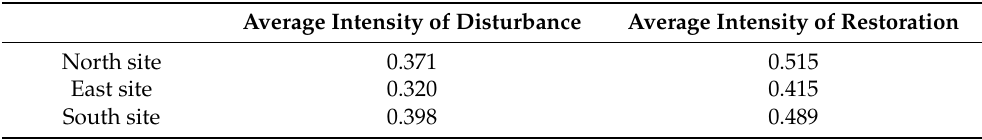
Table 5. Average intensity of disturbance and restoration of the